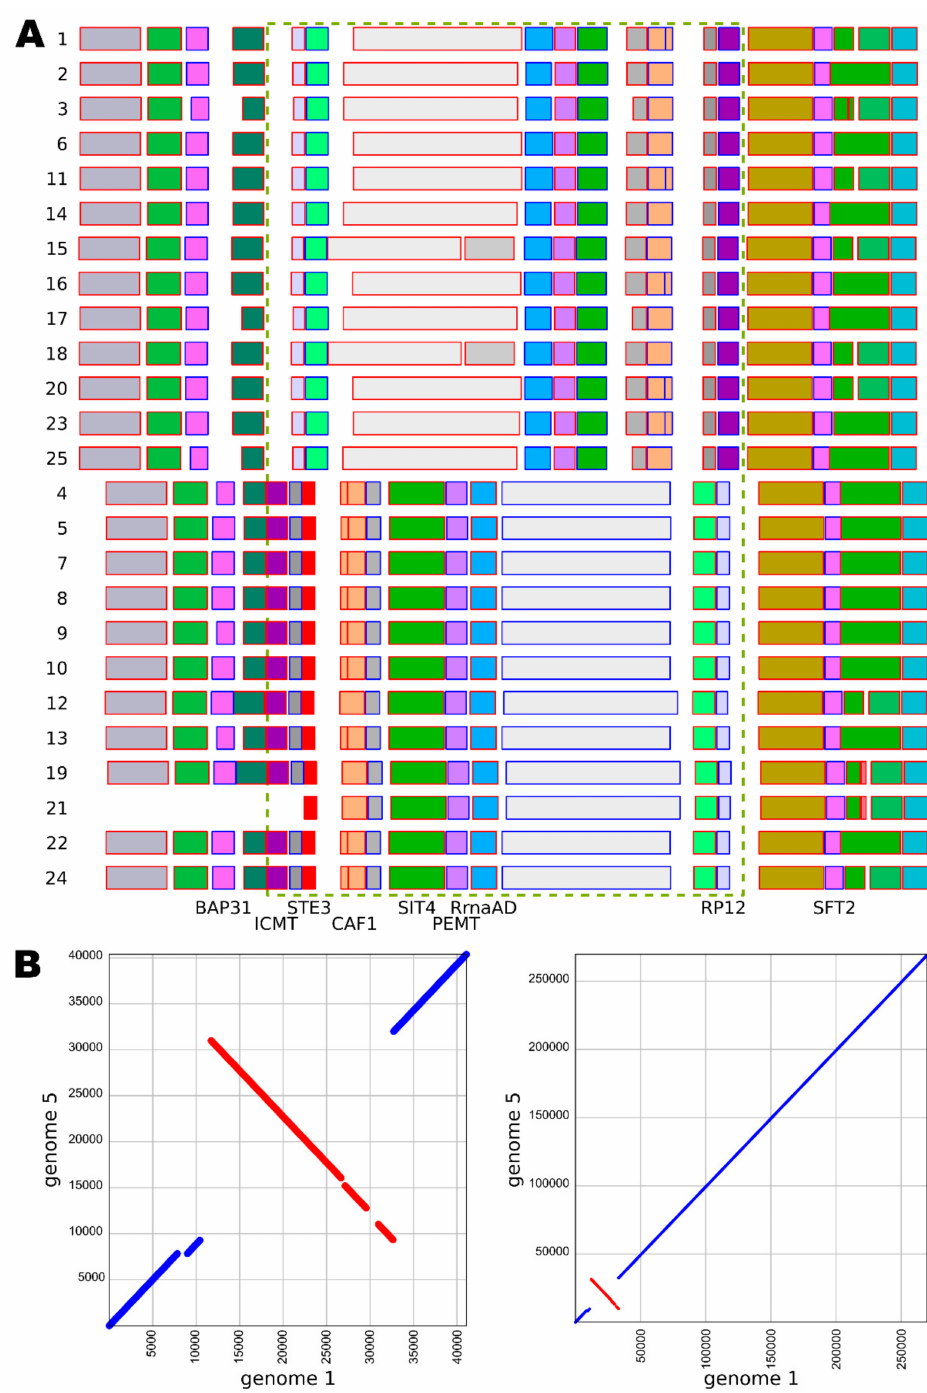
Figure 4. Putative mating-type loci in di ff erent strains of Wallemia mellicola . ( A ) Annotated mating-type loci and their flanking regions with putative gene functions assigned according to Padamsee et al. [8]. The chromosomal inversion is marked with a dashed green rectangle. Genome numbers are marked on the left. The blue or red outline of the rectangles representing the genes shows the gene orientation: left to right (blue) or right to left (red). ( B ) Alignment of the contigs containing the putative mating-type loci from the genomes 1 ( x axis) and 5 ( y axis) at di ff erent